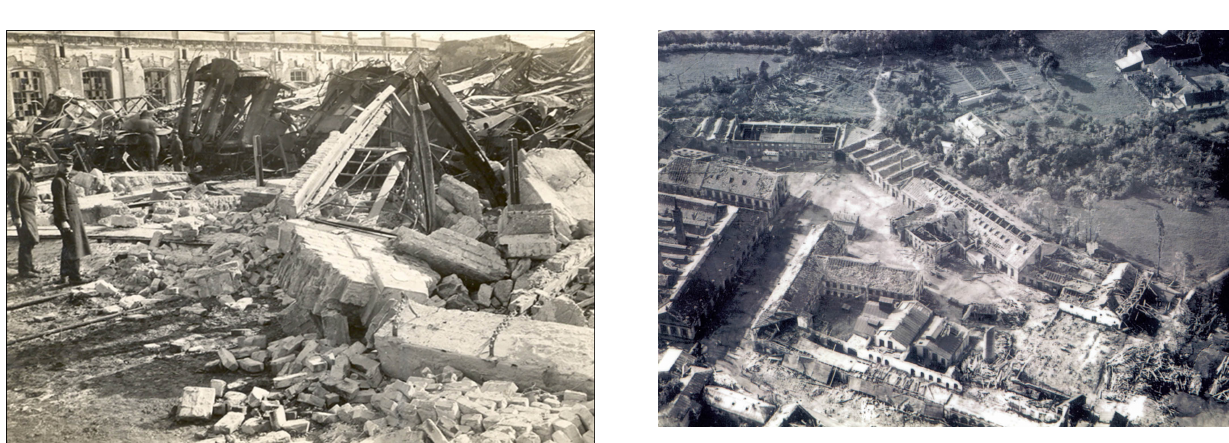
Figure 5. Aerial view of parts of the most damaged old locomotive factory. The area in the lower right quarter of the photo suffered the highest levels of destruction. Source: Industrieviertelmuseum Wiener